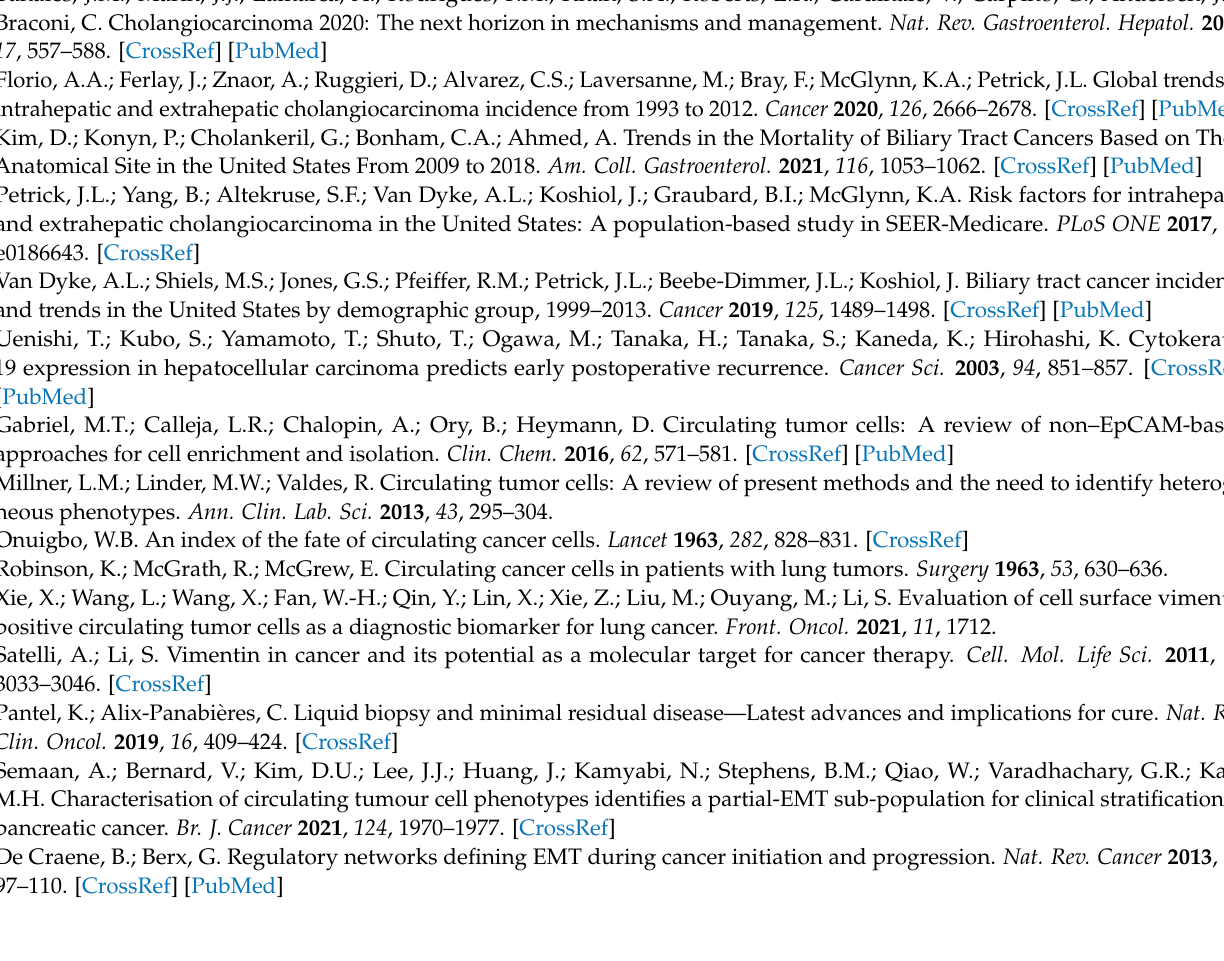
Table S2: comparison of PFS according to CTC marker and CA19-9 in 35 patients who underwent curative surgery or palliative chemotherapy, Table S3: Baseline characteristics between BTC patients with CTC detected and those without CTC detection, Figure S1: ROC curves of CTC, V-CTC, and